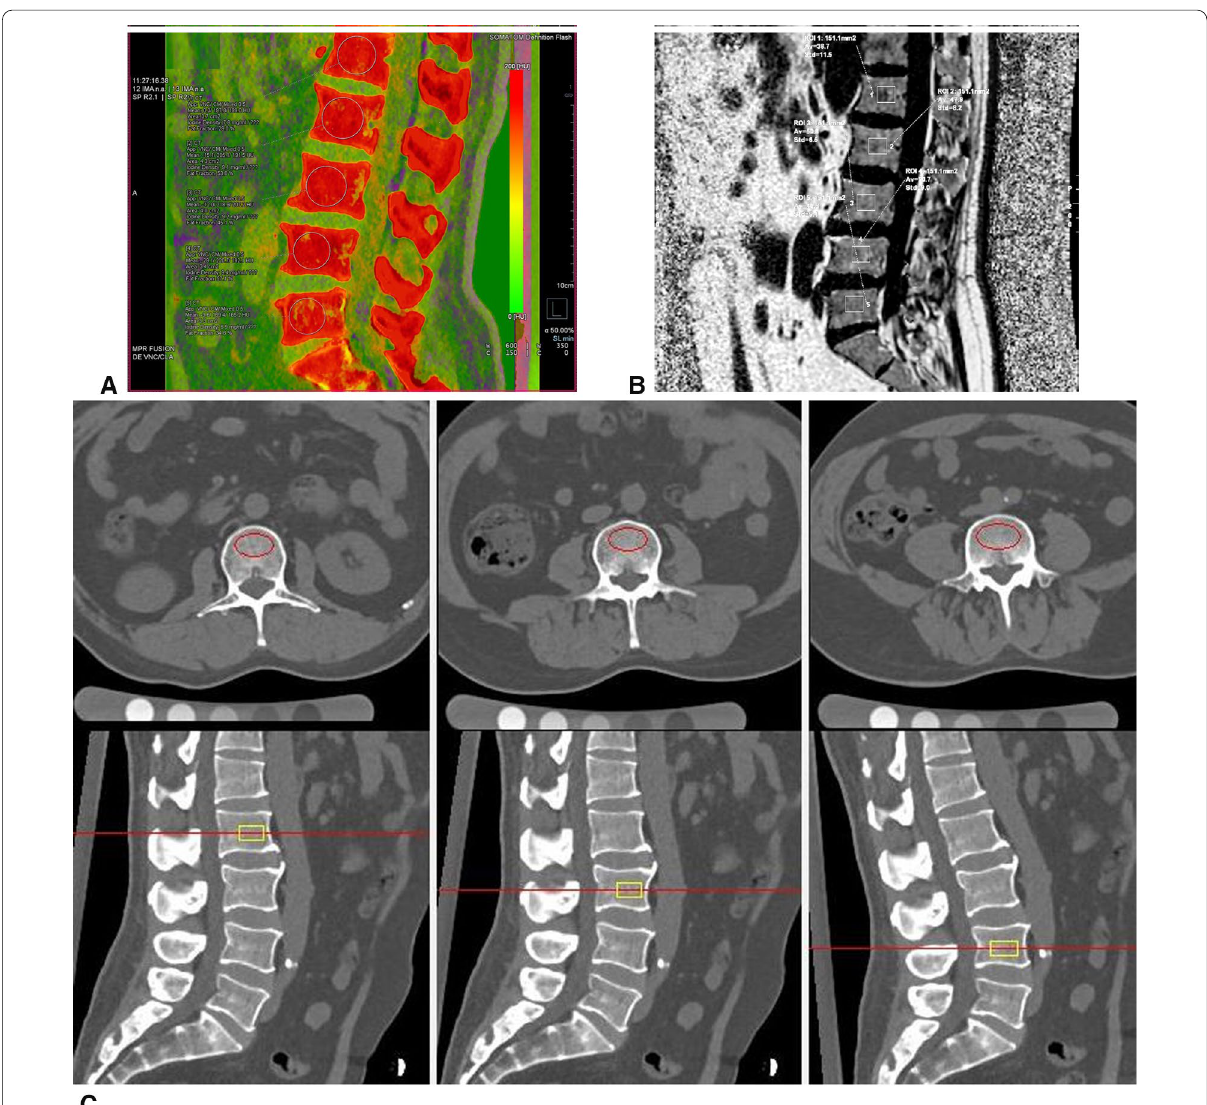
Fig. 2 Measurement of DECT-FF, MRI-FF, and BMD: A , B DECT-FF and MRI-FF derived from corresponding region of interest (ROI) in a standard median sagittal plane, respectively, and the ROI was delineated in 2/3 of the anterior vertebral body, avoiding the bone cortex, vertebral vein sulcus, and surrounding osteosclerosis; C BMD determined by ROI automatically drawn with QCT analytics